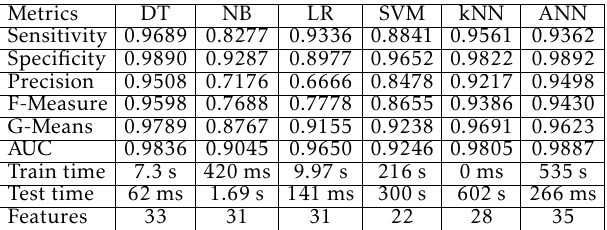
Table 26 compares the results of using GR-BFE with other algorithms. Thereby, GR-BFE gives the best Table 23. Results of using IG-BFE algorithm on DOS.